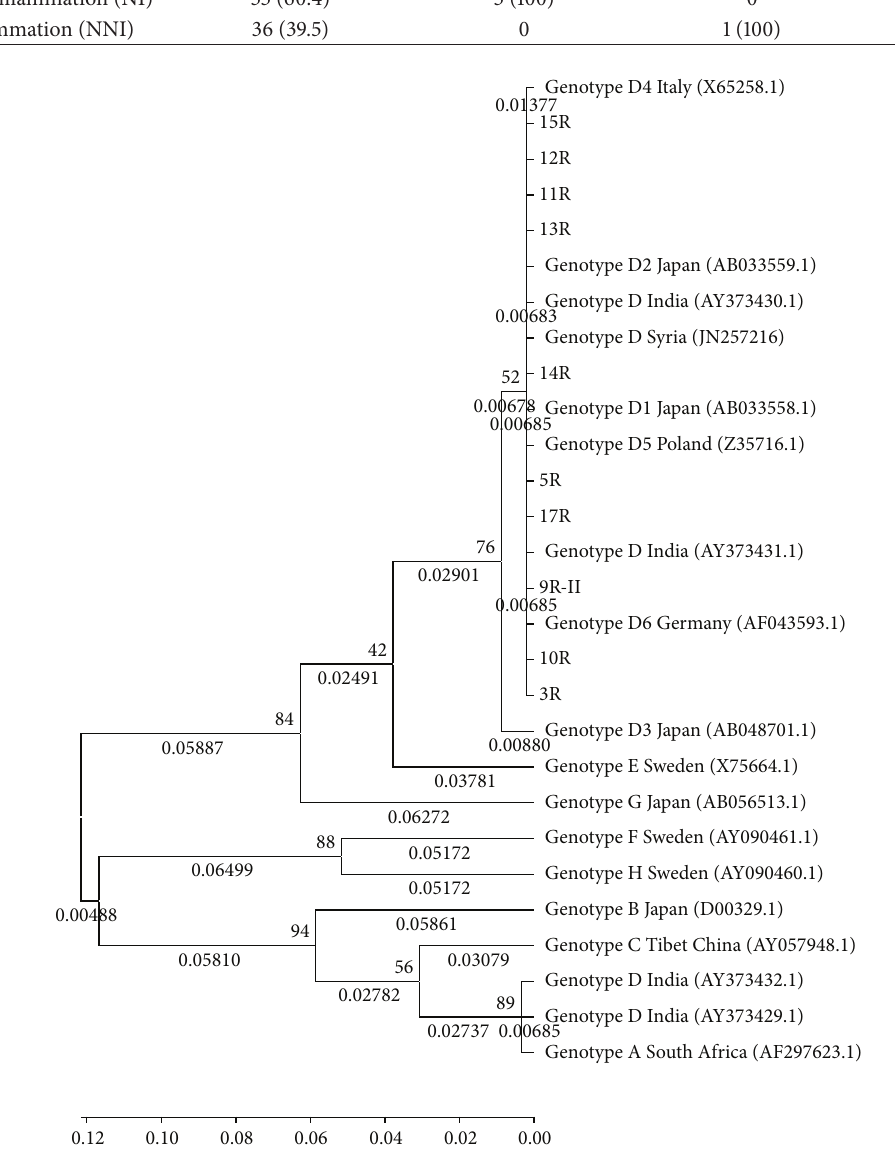
Figure 1: Phylogenetic analysis of isolates 3R, 5R, 9R, 10R, 11R, 12R, 13R, 14R, 15R, and 17R (genotype D) from Aligarh region was compared withreferencestrainsfromGenbank;phylogeneticanalysiswasbasedoncomparisonof305 bpoftheS-geneandconstructedusingneighbour joining method (bootstrap test of phylogeny). Robustness of the phylogenetic analysis was evaluated by a 1000 bootstrap replications. Genetic distances were calculated using the Kimura 2-parameter model of nucleotide substitution, MEGA 4